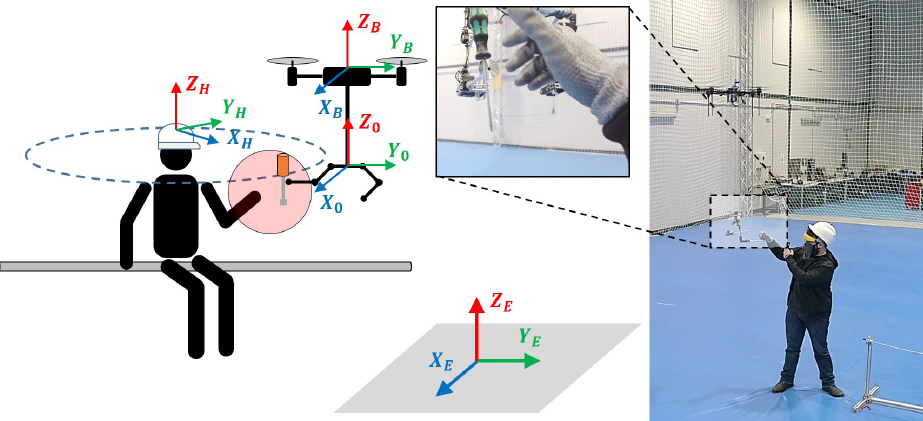
Figure 12. Reference frames in the aerial delivery application ( left ). Aerial tool delivery to a human operator with a dual-arm aerial manipulator in a long-reach configuration ( right